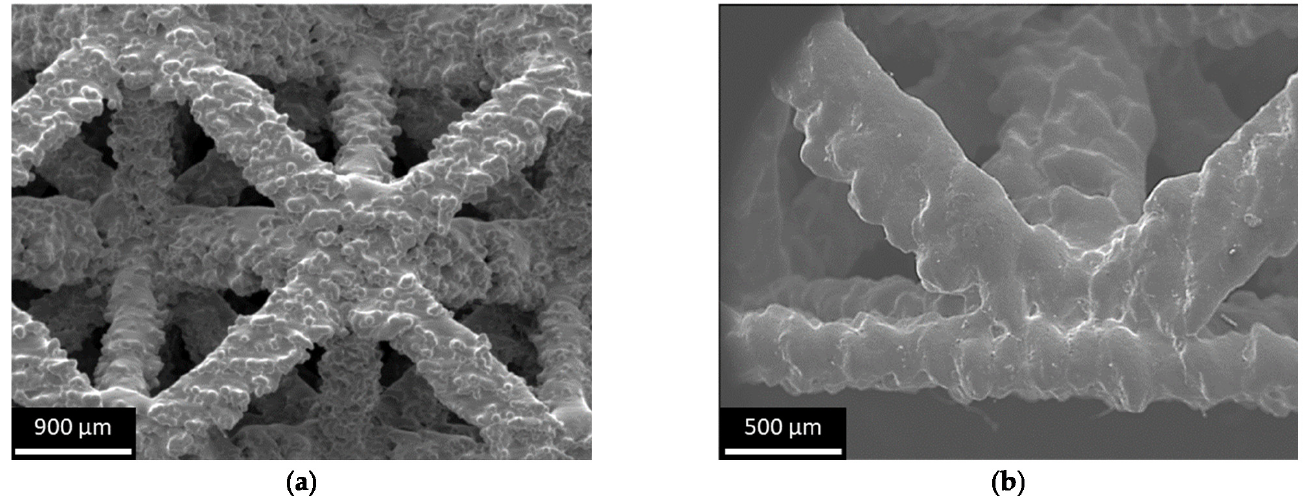
Figure 5. SEM micrography of the produced structures: ( a ) a node connecting some beams; ( b ) connection between skin and beams.